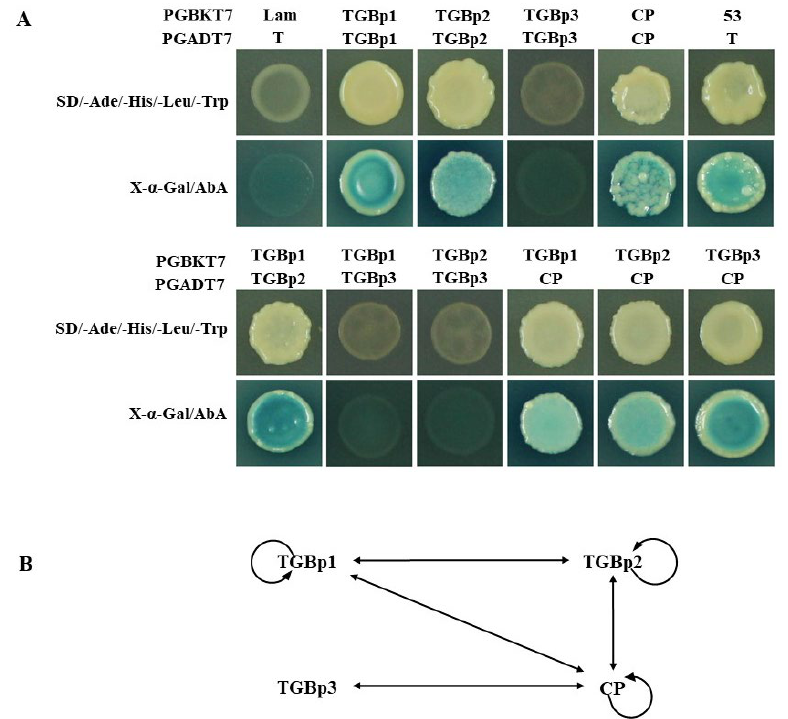
Figure 2. Yeast two-hybrid analysis of the protein-protein interactions of CYVCV. ( A ) Cells of a Saccharomyces cerevisiae strain Y2HGold were cotransformed with paired homologous proteins of TGBp1-TGBp1, TGBp2-TGBp2, TGBp3-TGBp3, CP-CP and heterologous proteins TGBp1-TGBp2, TGBp1-TGBp3, TGBp2-TGBp3, TGBp1-CP, TGBp2-CP, and TGBp3-CP. Their cDNAs were individually fused to pGBKT7 as bait plasmids (BD) and to pGADT7 as prey plasmids (AD). The pGBKT7-p53-pGADT7-T construct was used as a positive control, and pGBKT7-Lam-pGADT7-T was used as a negative control. Positive interactions were determined by the appearance of both white colonies and blue colonies on quadruple dropout agar medium SD/-Ade/-His/-Leu/-Trp (QDO) (upper panel) and QDO supplemented with X- α -Gal/AbA (lower panel), respectively. ( B ) A schematic showing the interaction relationship among CYVCV proteins as determined by Y2H. The circular heterologous